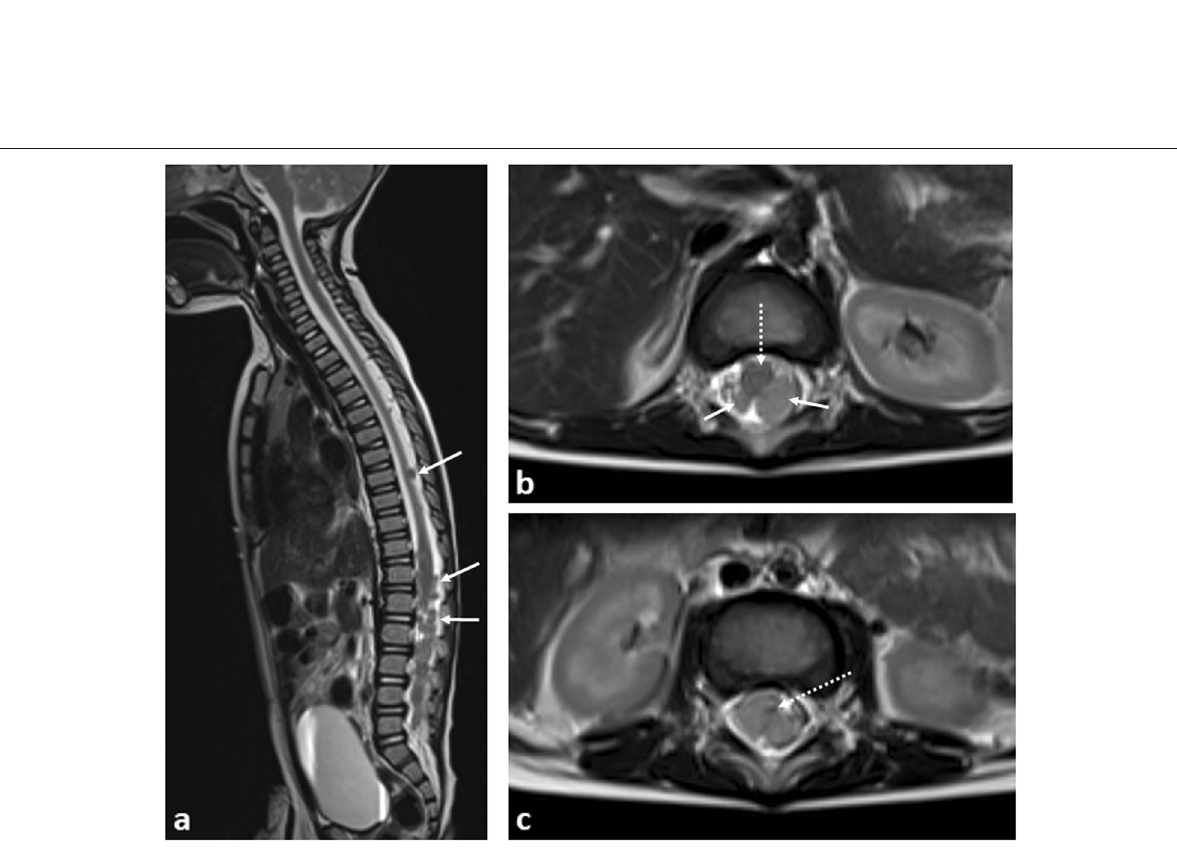
Fig. 3 A 9-month-old boy with disseminated spinal leptomeningeal disease secondary to an intracranial ATRT. a Sagittal T2-weighted MRI of the spine demonstrates numerous extra-medullary, intraspinal tumour deposits (arrows). b Axial T2-weighted MRI of the lumbar spine demonstrate how these deposits (arrows) occupy the majority of the spinal canal, with the spinal cord (dashed arrow) anteriorly displaced, and ( c ) eventually becoming compressed at the cauda equina, where it is barely visible (dashed arrow). Emergency intrathecal chemotherapy and radiotherapy was subsequently